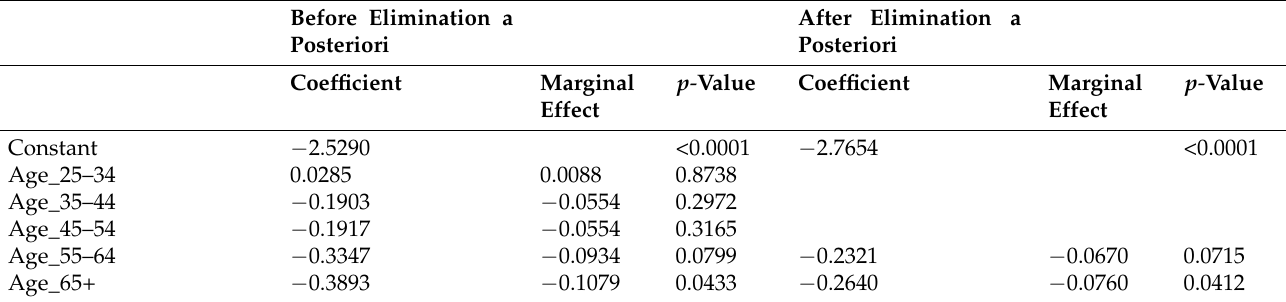
Table 7. The results of the estimated probit model before and after elimination a posteriori ( n =